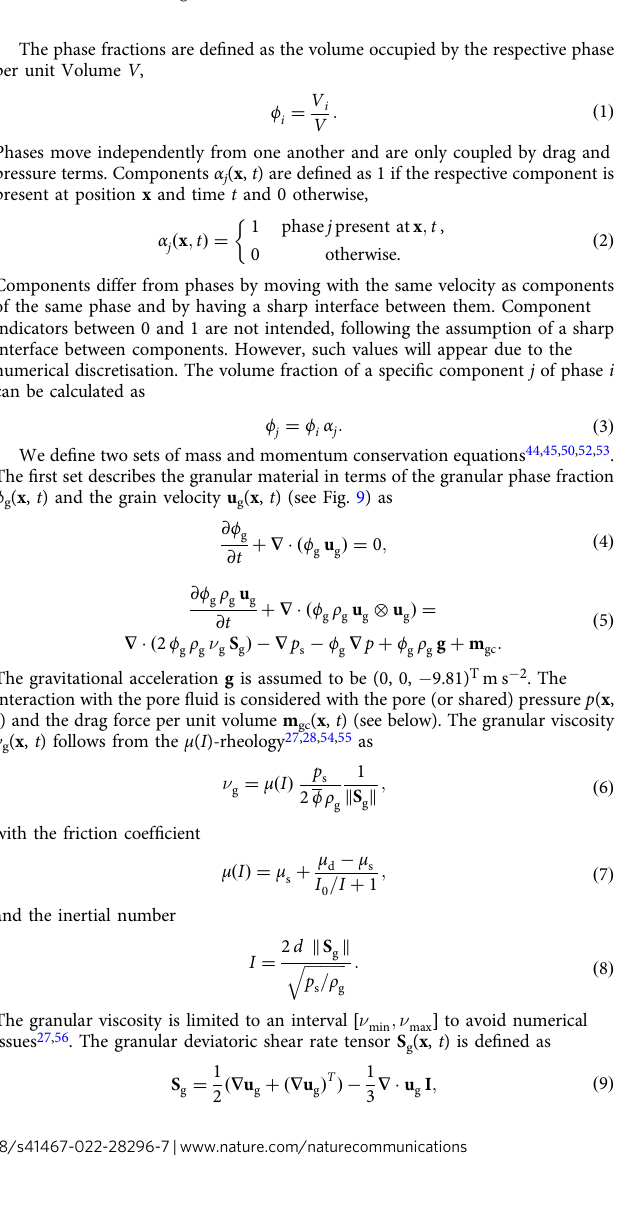
Fig. 9 Sketch of the mathematical model of a dry subaerial landslide impacting a water reservoir and generating a tsunami. The mathematical model of this process is de fi ned in terms of phase fractions ϕ g and ϕ c , component indicator functions α a = ϕ a /( ϕ a + ϕ w ) and α w = ϕ w /( ϕ a + ϕ w ) and phase velocities u g and u c